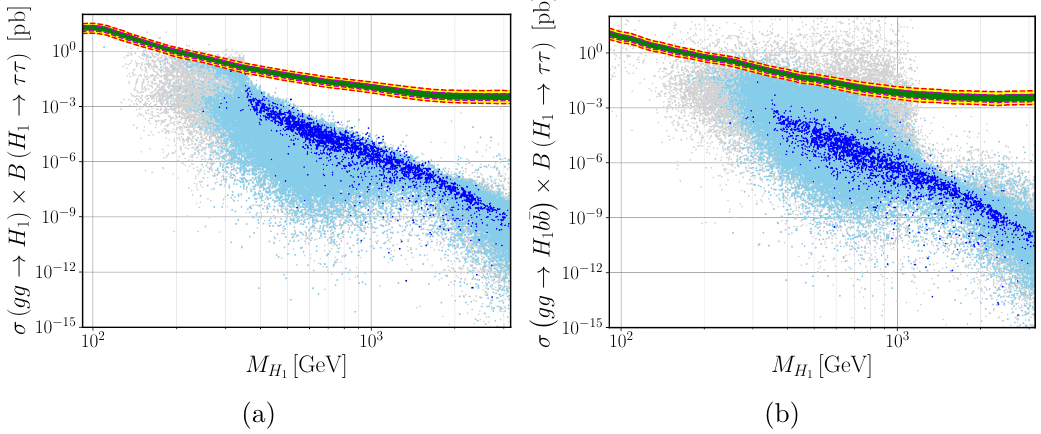
Figure 10 . The signal strength for production of a CP-even scalar via the gluon-gluon fusion mechanism (a) times its branching ratio to τ ¯ τ , and (b) with associated production of a b ¯ b -pair times its branching fraction to τ ¯ τ , as a function of the lightest CP-even mass, m code is the same as in figure 9 and the exclusion bounds in both panels were also taken from